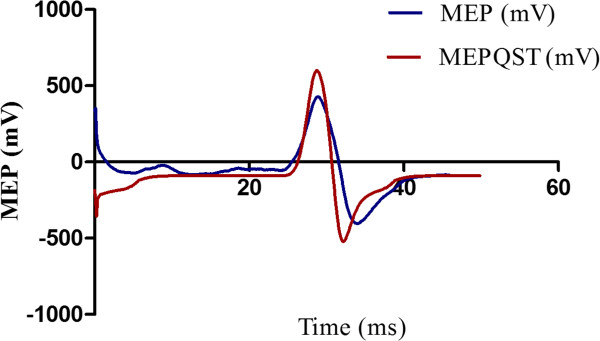
Example of 10 averaged transcranial magnetic stimulus-induced Motor Evoked Potentials at the First Dorsal Interosseus (FDI), before (MEP) and after (MEPQST) the Quantitative Sensory Testing (QST).